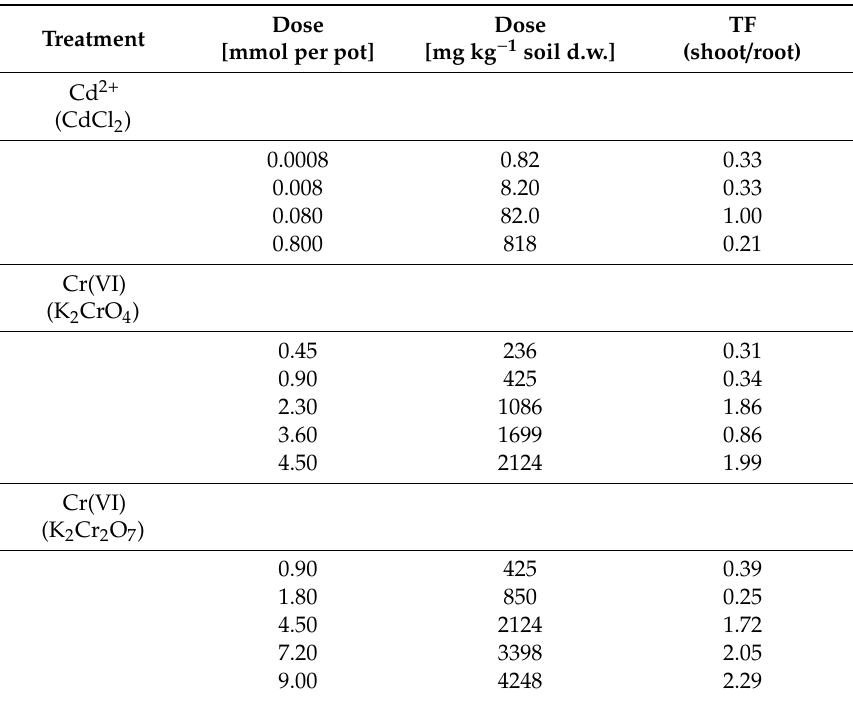
Figure 3. Cadmium bioaccumulation factors (BAF) of Mesembryanthemum crystallinum roots and shoots as determined for plants subjected to treatment with different Cd doses, ranging from 0.8 to 800 µ mol of Cd applied per pot (N = 3, mean values ± SD). Table 2. Cd and Cr translocation factors (TF) calculated upon treatment of the common ice plant, Mesembryanthemum crystallinum , in a soil pot test.